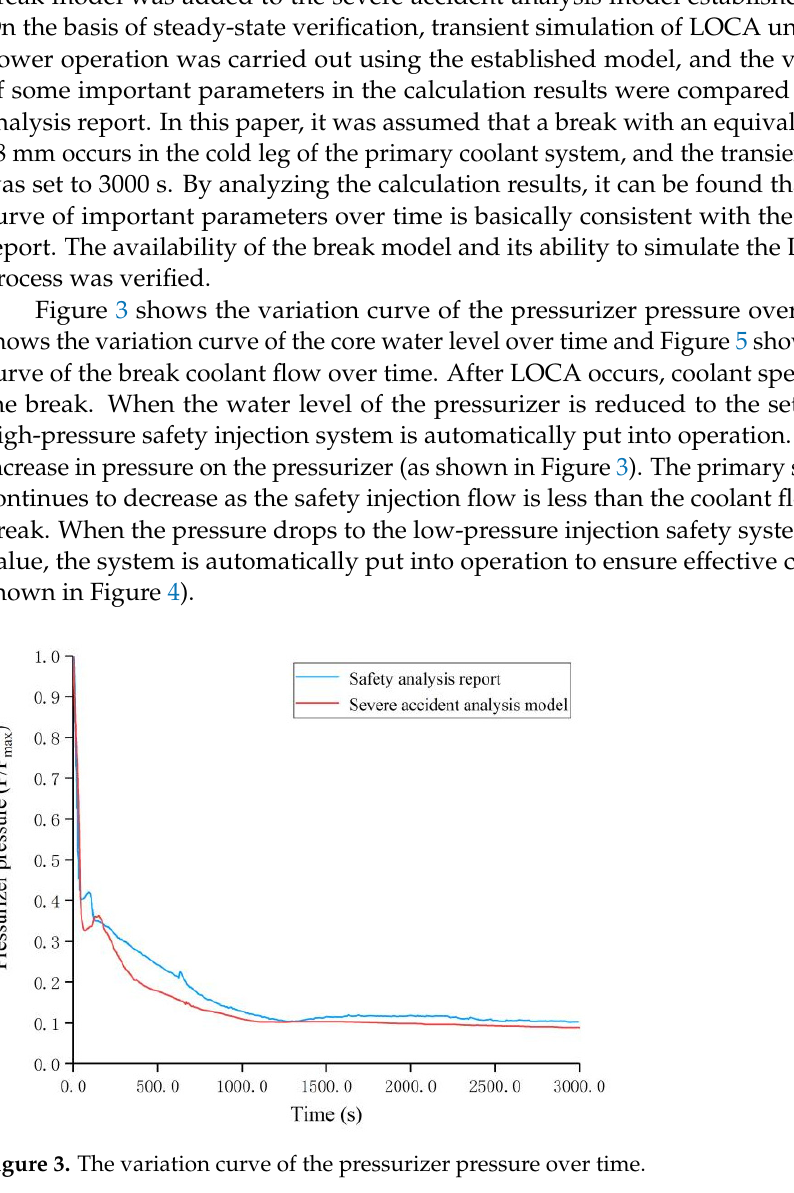
Figure 4. The variation curve of the core water level over time. Figure 5. The variation curve of the break coolant flow over time.